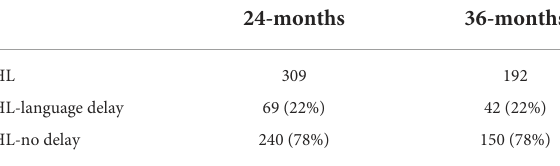
TABLE 7 Number of infants identified to have language delays among HL-infants by